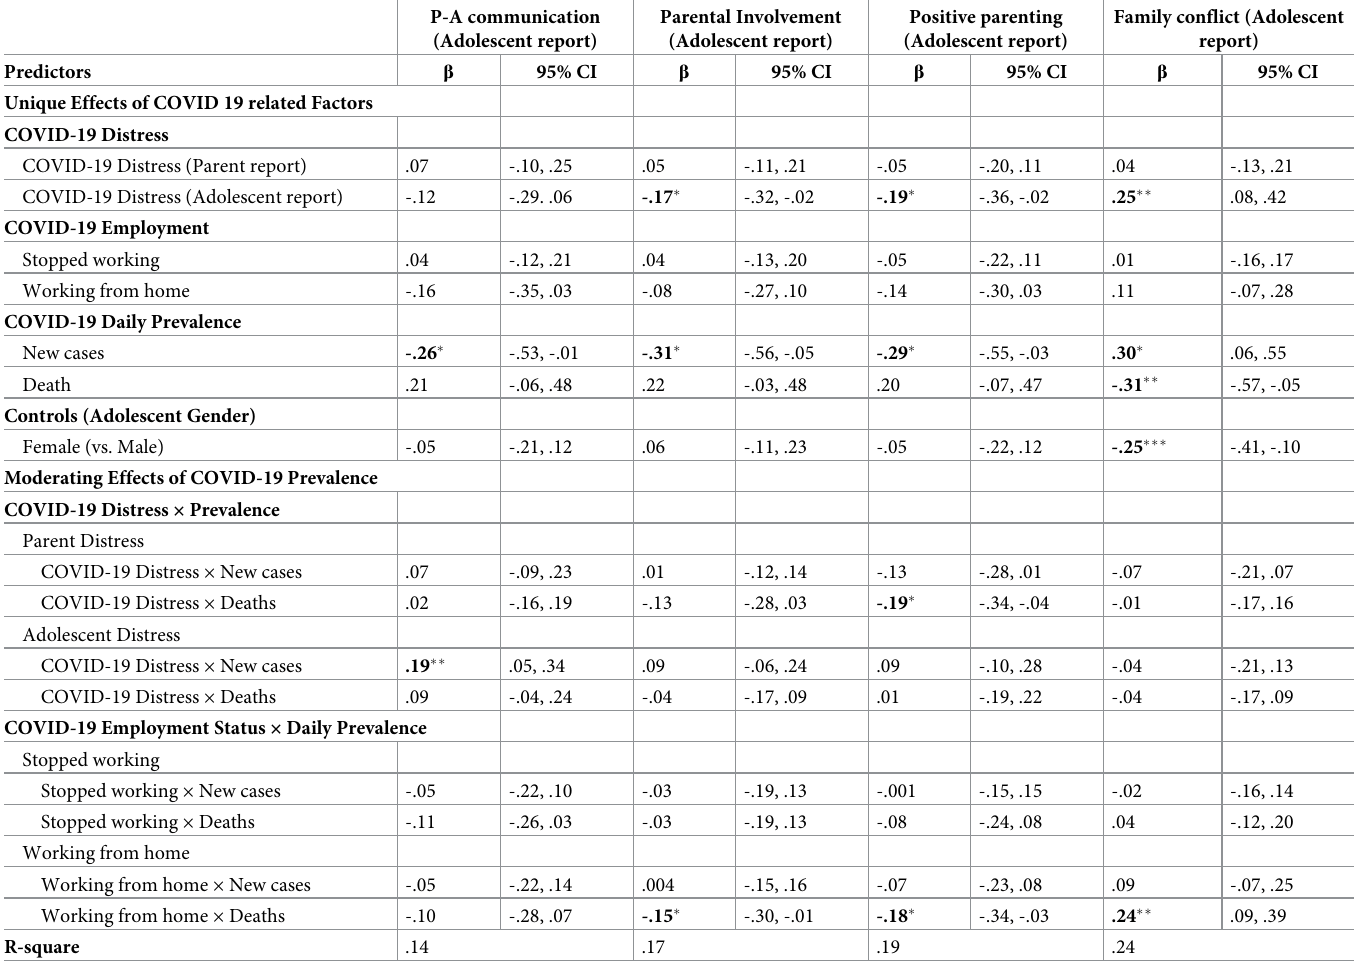
Table 3. Unique and moderating effects of COVID-19 related factors on adolescent’s perception of family